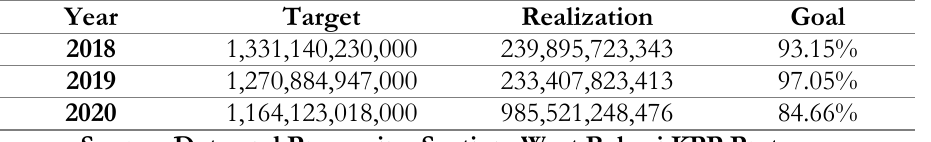
Target and Realization of Tax Revenue in West Bekasi KPP Pratama in